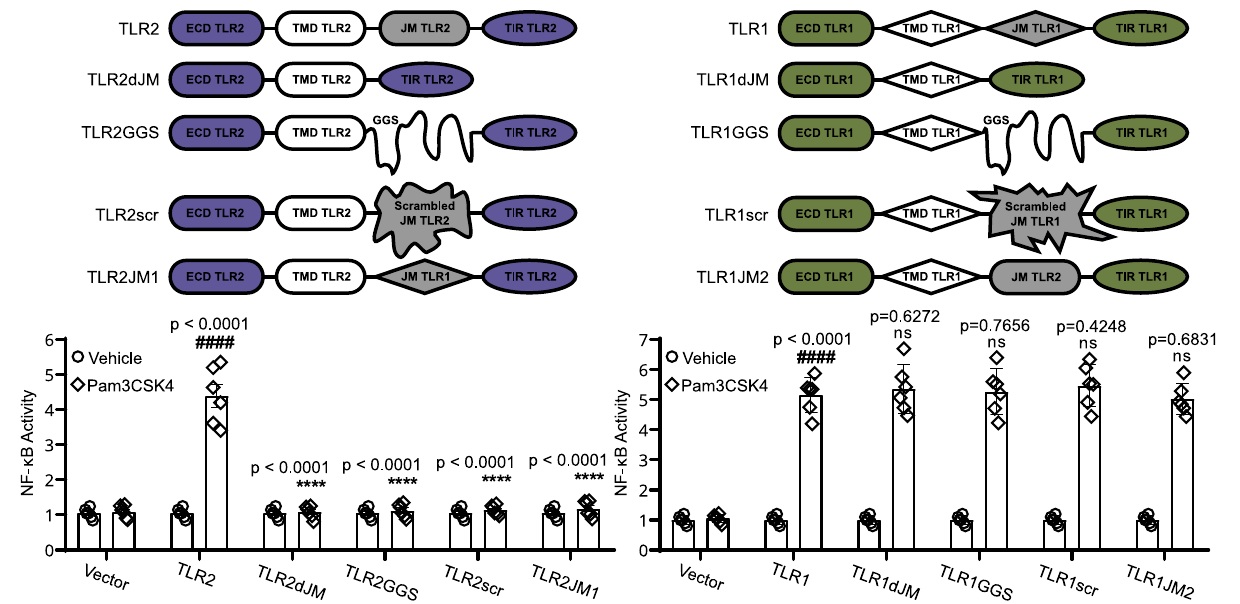
Fig. 6 | Functional role of JM helix in the functioning of TLR1/TLR2 receptor. Shown is the NF- κ B activity measured for TLR1 and TLR2 constructs upon stimu- lation with Pam3CSK4 ( n =6). Data are represented as mean±SD. Statistical sig- ni fi cance according to the unpaired two-tailed Student ’ s t test is indicated as